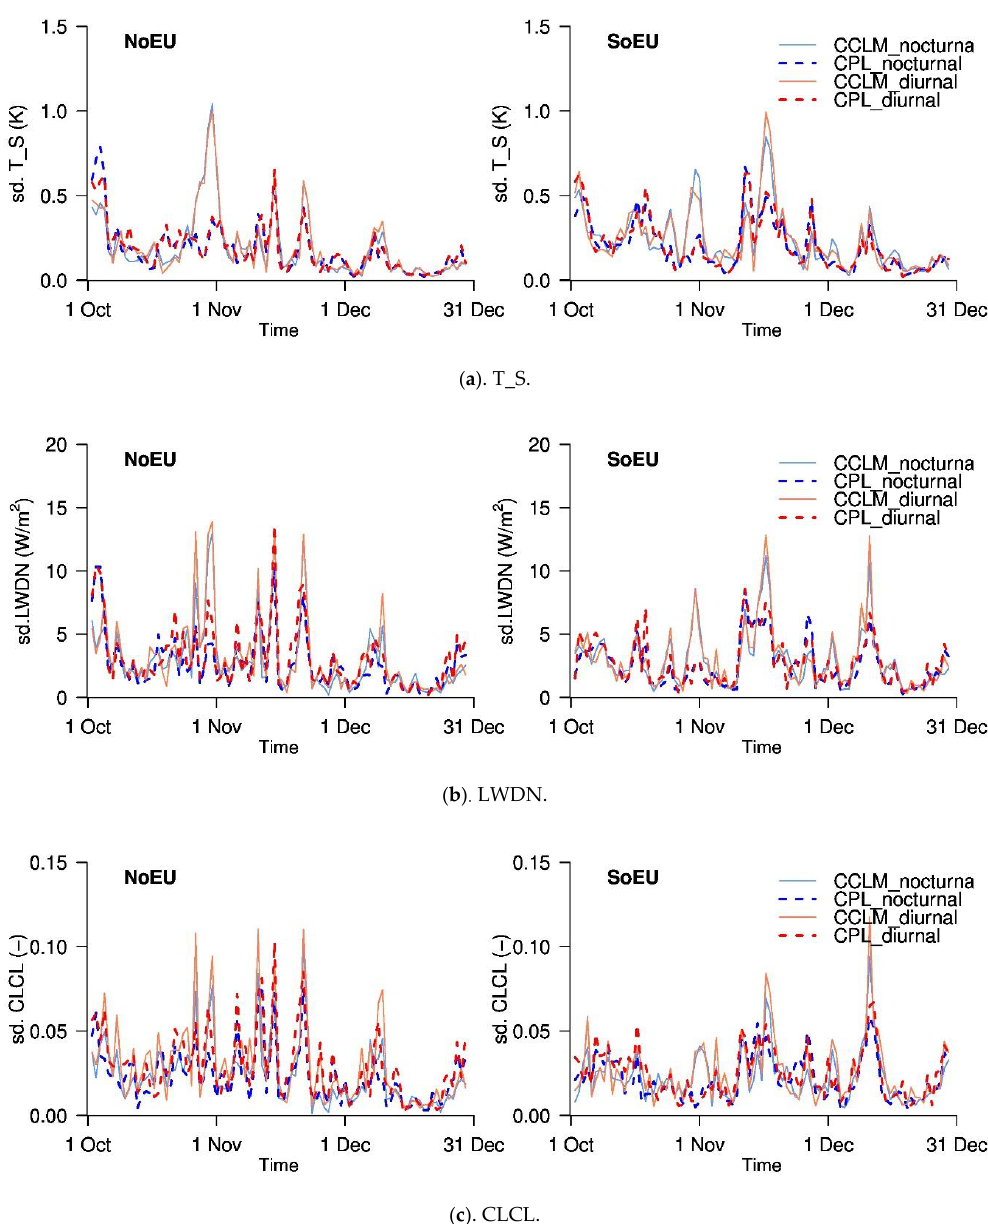
Figure 12. Daily mean standard deviation of ( a ) surface temperature T_S (K), ( b ) surface longwave downward radiation LWDN (W / m 2 ) and ( c ) low-level cloud cover CLCL (–) averaged for NoEU ( left ) and SoEU ( right ) during night time (nocturnal, bluish color) and day time (diurnal, reddish color) of stand-alone CCLM (solid line) and AHOI (dashed line) Time period: 1 October–31 December 2013. For all variables, we consider daytime (diurnal, from 6 UTC to 17 UTC) and nighttime (nocturnal, from 18 UTC to 5 UTC of the next day) values during 1 October–31 December 2013. September is excluded in Figure 12 as the spin-up time. Figure 12 shows that variability magnitudes of AHOI (dashed lines) are often smaller than those for CCLM_ctr (solid lines), especially during the storm Christian event, and the difference between AHOI and CCLM_ctr is more pronounced over NoEU than over SoEU. The spread of T_S and T_2M of CCLM_ctr over NoEU is about 0.5 degrees